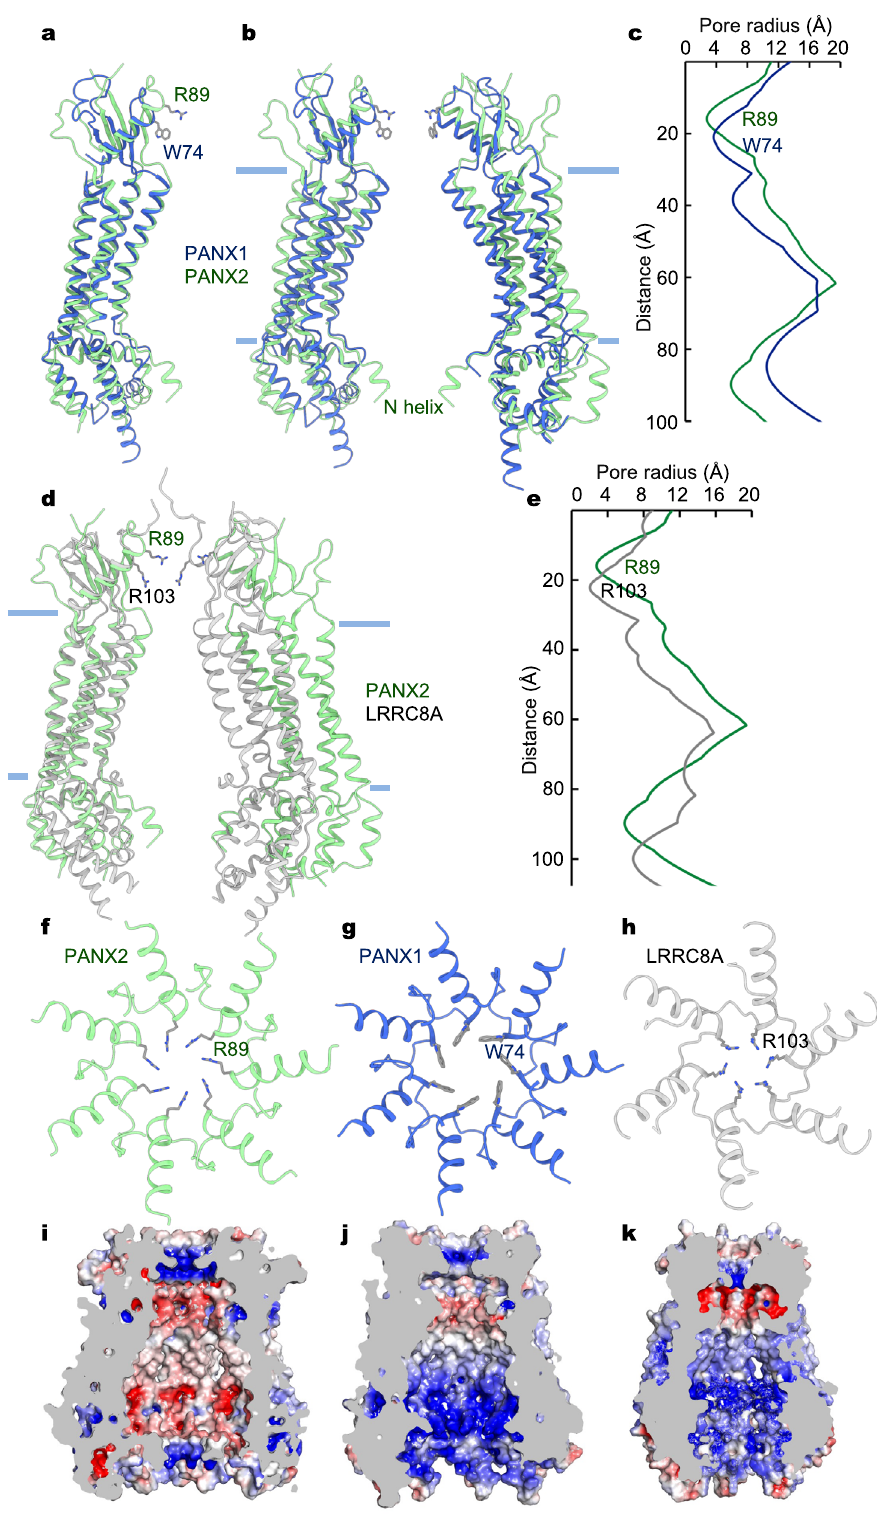
Fig. 4 | Pore properties of PANX2, PANX1, and LRRC8A channels. a Superposition of PANX2 (green) and PANX1 (blue) protomers (PDB: 6UZY). b Superposition of the heptameric PANX2 and PANX1 channels. Only twosubunits are shown. c Pore pro fi les of PANX2 and PANX1. d Overlay of heptameric PANX2 (green) and hexameric LRRC8A (gray, PDB: 6NZW) channels based on